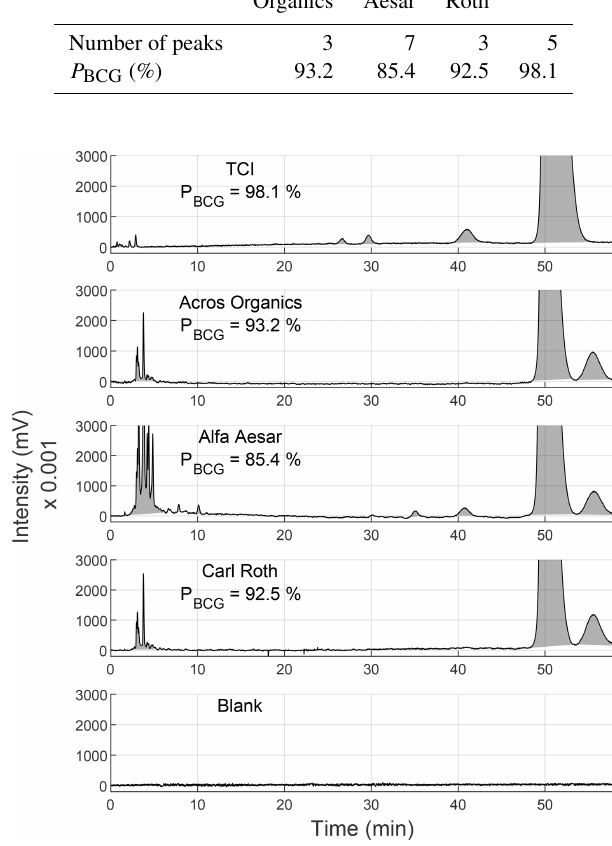
Figure 2. Analytical HPLC chromatograms of unpurified BCG from different vendors with their P BCG and a chromatogram from a solvent injection without BCG (Blank). All peaks are highlighted with gray background color.